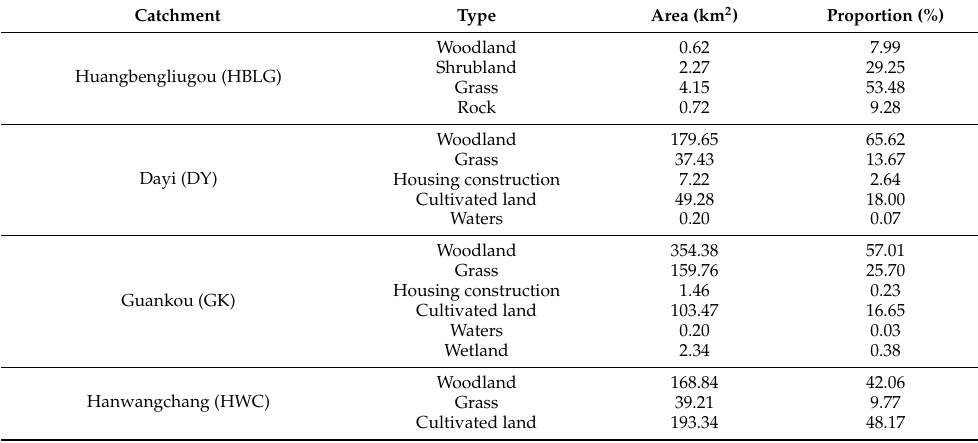
Figure 1. The Huangbengliugou (HBLG) catchment. Table 1. Land use types.